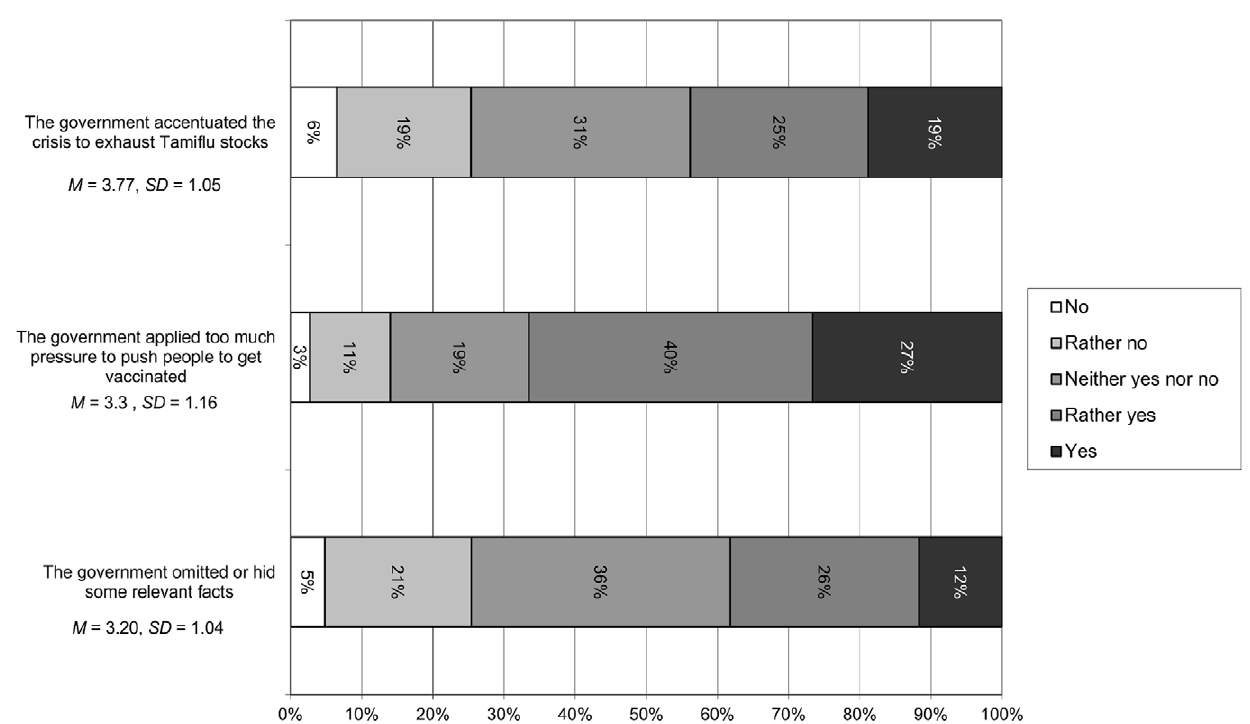
Figure 4. Perceptions of the Role of the Government, Wave 2.